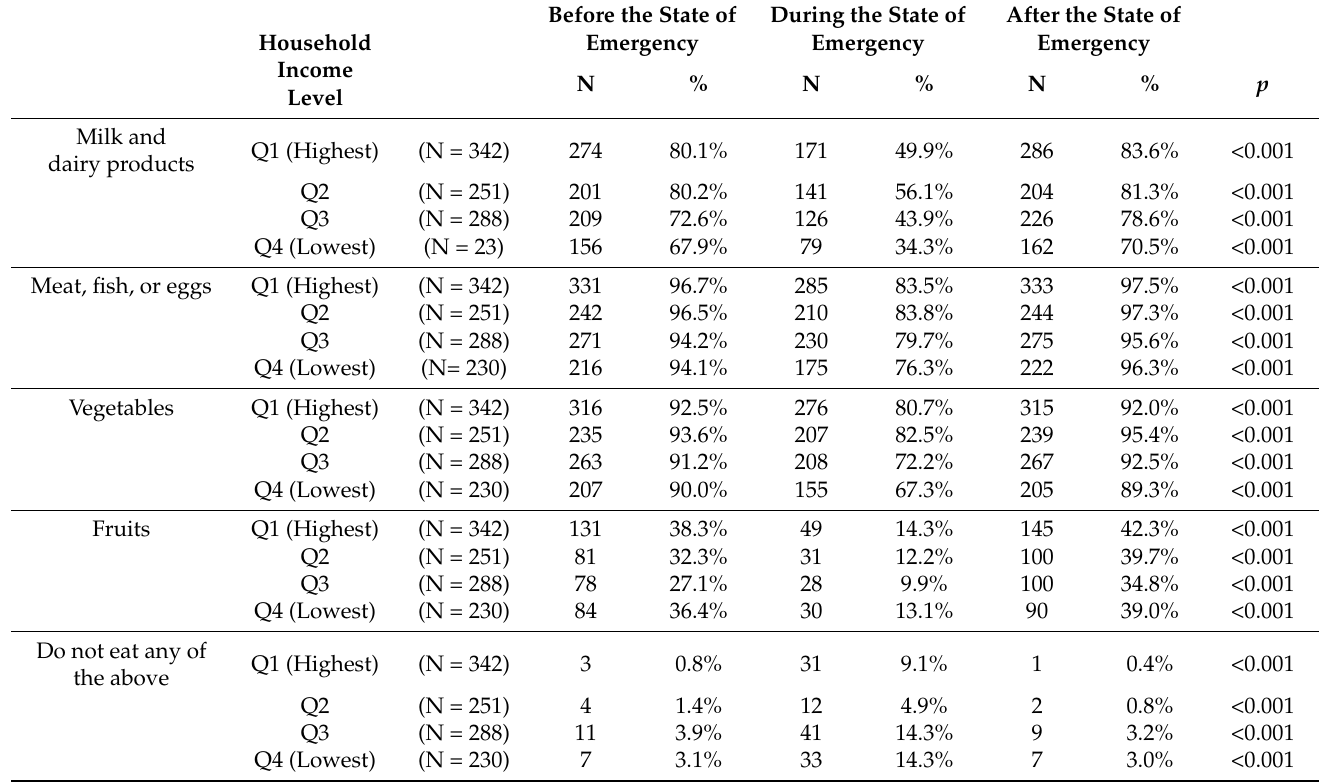
Table 3. Prevalence of intake of selected food groups at least twice a day according to household income level: